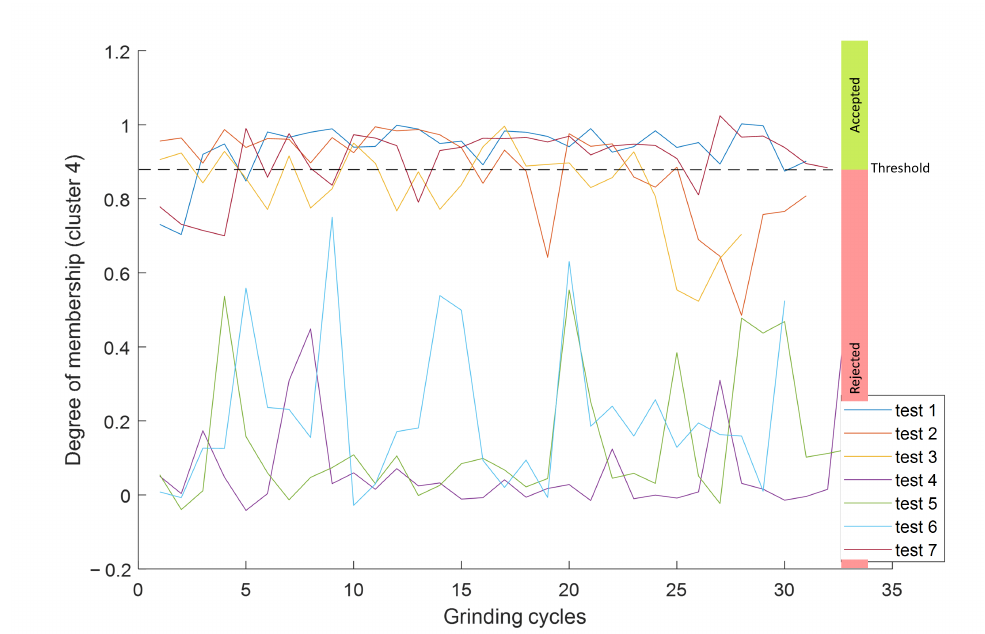
Figure 12. Predicting the overall ring quality produced in test data. The dashed line represents the threshold above which the quality is acceptable.